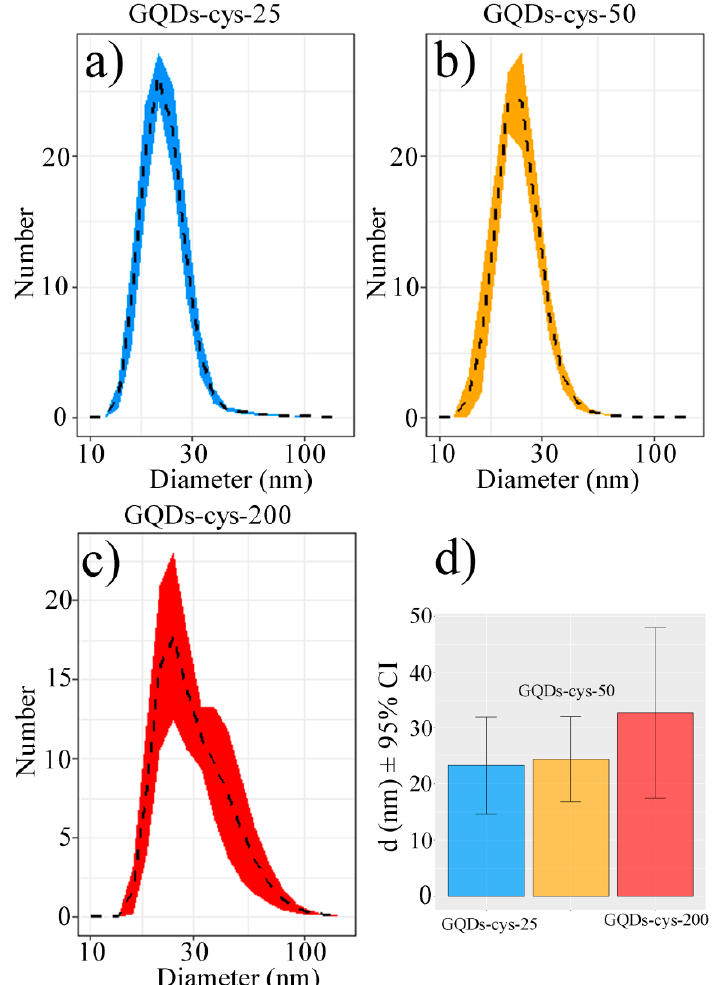
Figure 4. Average number-weighted diameter distribution function for GQD-cys-25 ( a ), GQD-cys-50 ( b ), GQD-cys-200 ( c ) and mean diameter ( d ). The results show that both GQD-cys-25 and GQD-cys-50 had a similar shape of the diameter distribution function, while GQD-cys-200 was strongly right-skewed, with a heavy right tail. The average hydrodynamic diameter was approximately 23, 24 and 27 nm for GQD-cys-25, GQD-cys-50 and GQD-cys-200, respectively (Figure 4d). The follow- ing average PDI values were measured: 0.37 (GQD-cys-25), 0.35 (GQD-cys-50), and 0.23